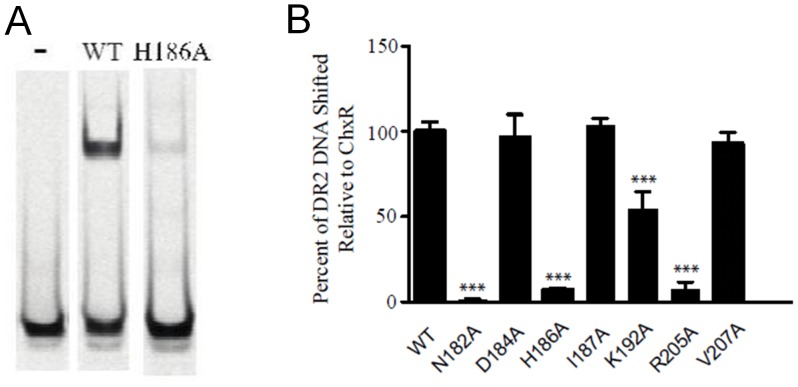
Site-directed mutagenesis identifies DNA-binding residues within ChxR.
A, Alanine substitutions were generated in several of the residues within regions (α5–α6 and β11–β12) known to interact with DNA in other OmpR/PhoB subfamily members. Representative EMSA of IR800-labeled DNA in the absence of ChxR (-) and in the presence of 44 μM wild-type ChxR or 44 μM ChxRH186A. B, The amount of DNA shifted with each substitution was quantified. DNA binding of four substitutions (Asn182, His186, Lys192, and Arg205) was significantly (p<0.001 (***)) reduced relative to wild-type ChxR.